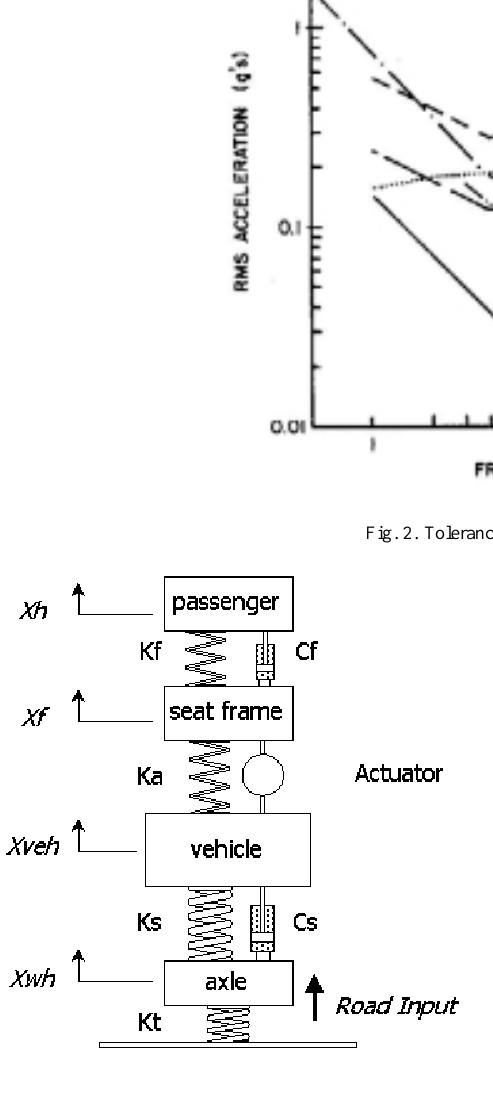
Fig. 3. Four-degree-of-freedom quarter-car and seat